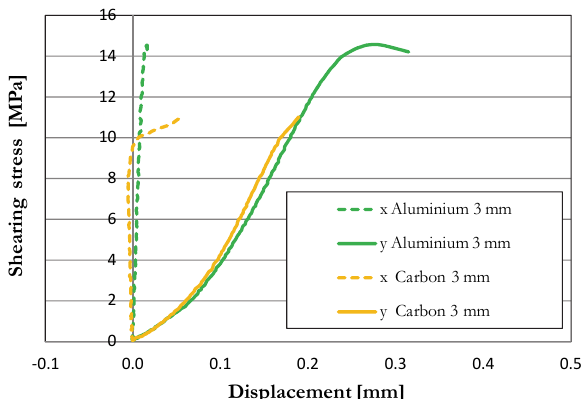
Figure 12: Variation of local relative displacements for aluminium and carbon 3 mm